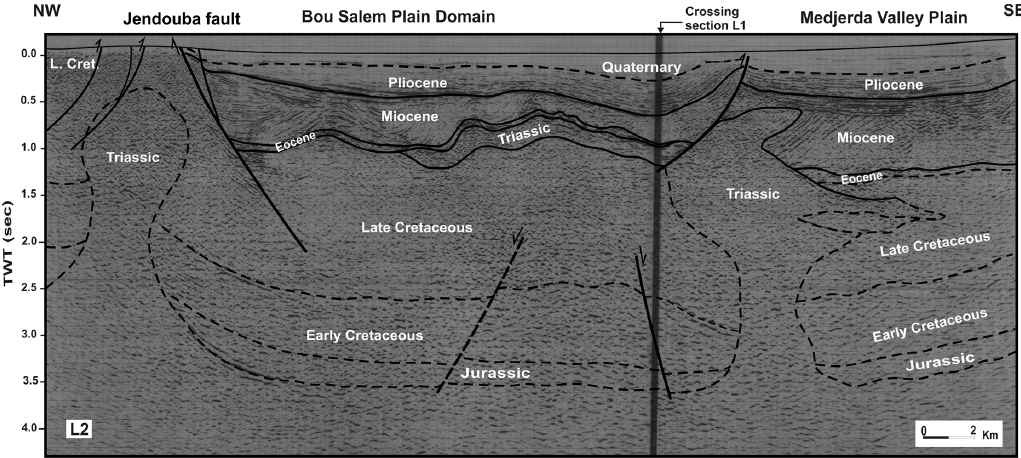
Figure 10. Interpreted seismic line L2 across the Medjerda Valley Plain (location shown in Figure 1), illustrating distribution of the Meso- zoic and Cenozoic strata and their relation with the NE–trending faults, E–W faults, and associated Triassic